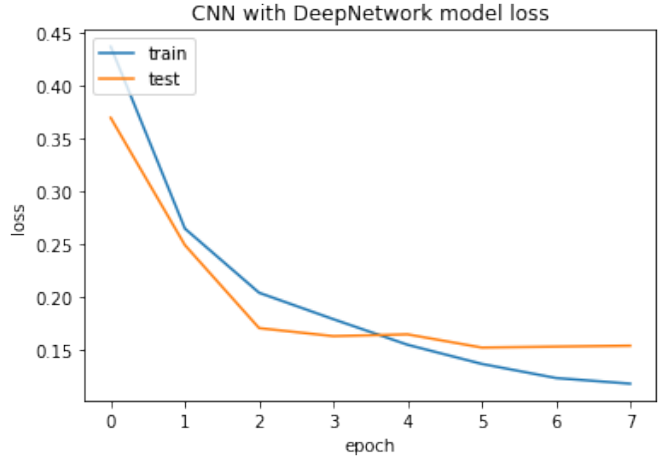
Figure 27. CNN with DeepNetwork model loss.